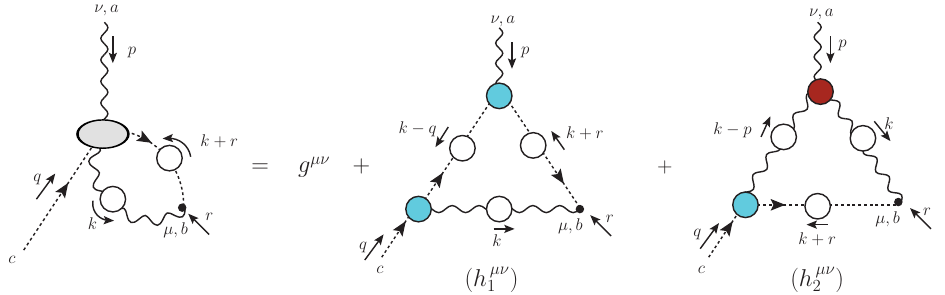
Figure 19. SDE for the ghost–gluon scattering kernel, H µν ( r , q , p ) . We omit a diagram containing a 1PI four-point